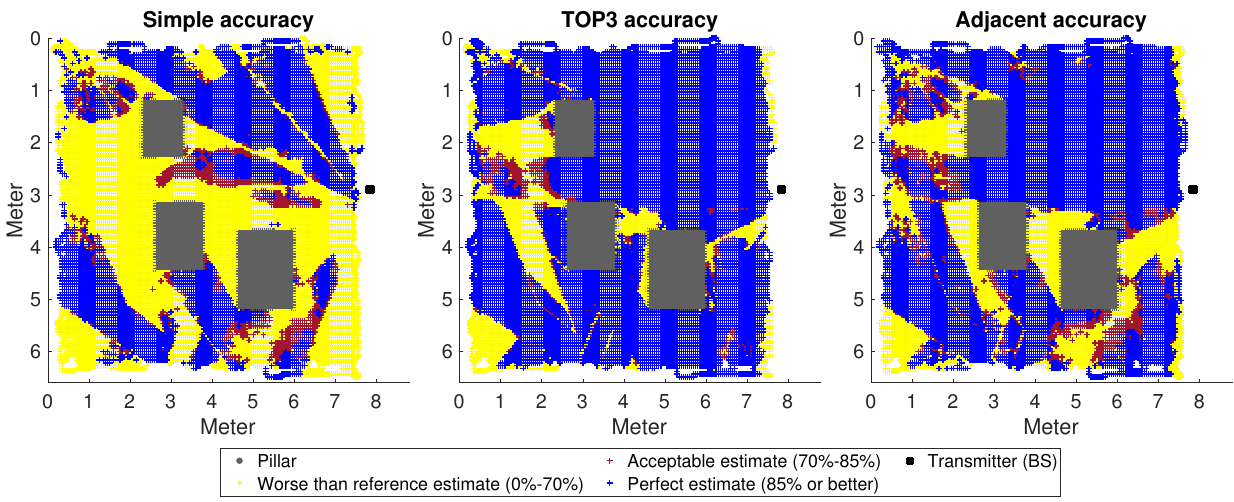
Figure 7. A movement of 5,000,000 steps in Room A3; the accuracy interpreted according to the metrics is presented. The areas marked in white were not visited during the